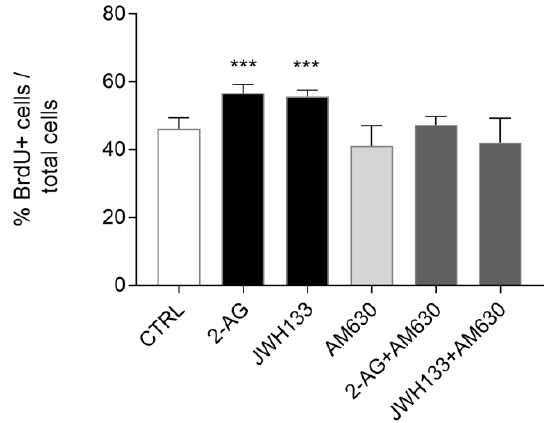
Figure 4. Evaluation of the effects of 2-AG and JWH133 alone or in the presence of the specific CB2 antagonist AM630 on ST14A cell proliferation rate. Results are shown as ratio (%) of the number of BrdU+ cells over the number of total cells, stained with DAPI fluorophore. After 24 h treatment with 2-AG (5 µ M) and JWH133 (300 nM) an increase in BrdU incorporation was observed, with respect to untreated cells (CTRL); the effect was specifically reverted in both the cases by 300 nM AM630 coadministration. Data are expressed as mean ± standard deviation (SD); n = 3 replicates (5 random fields counted in each well), 3 independent experiments. *** = p ≤ 0.001 vs.